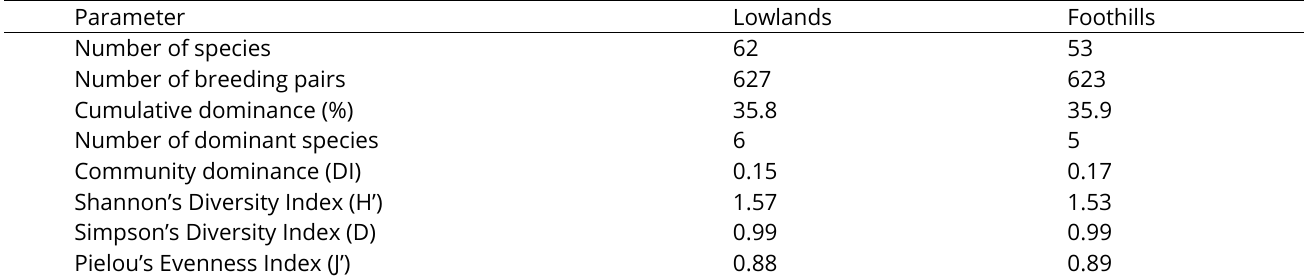
Table 2. Parameters and indices characterizing breeding bird community in the lowland and foothill farmlands in Lesotho. Parameter Lowlands Foothills Number of species 62 53 Number of breeding pairs 627 623 Cumulative dominance (%) 35.8 35.9 Number of dominant species 6 5 Community dominance (DI) 0.15 0.17